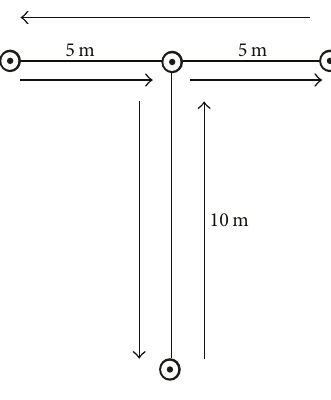
Figure 3: t -Test.